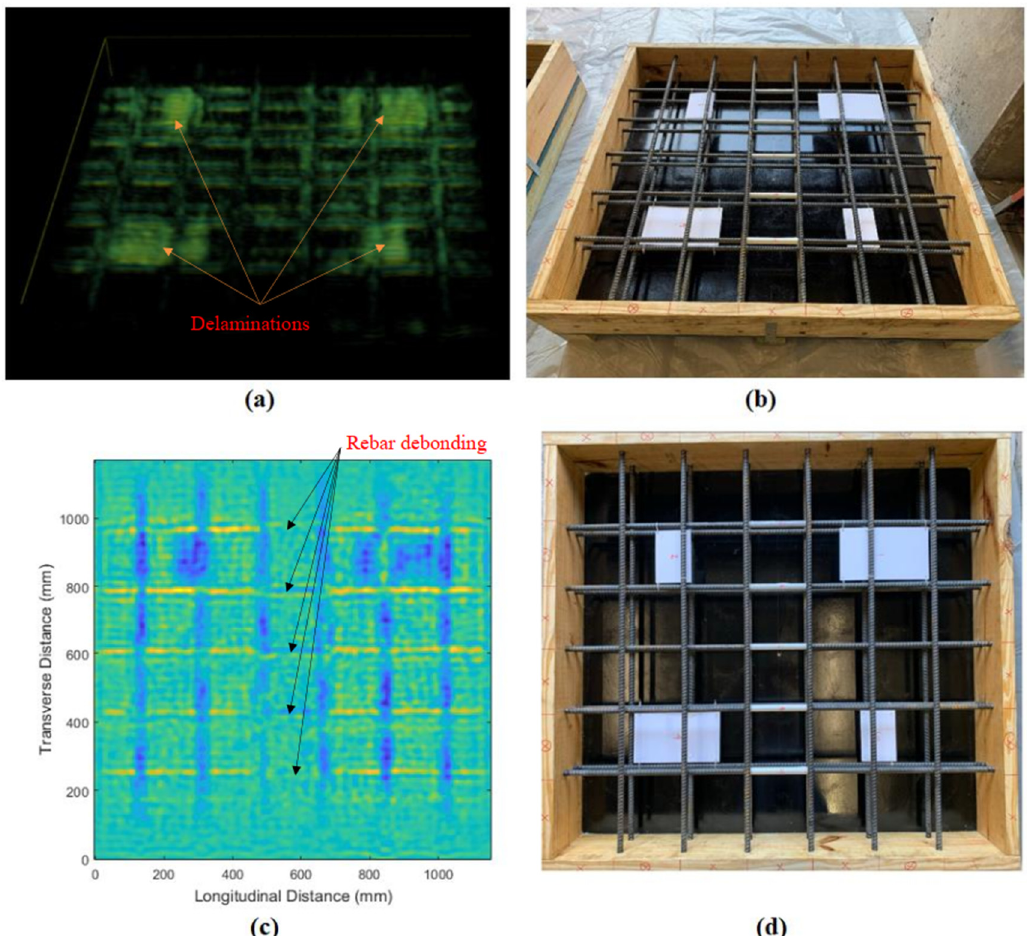
Figure 10. Imaging results for slab 5 from di ff erent view angles ( a , c ) versus ground truth ( b , d ).